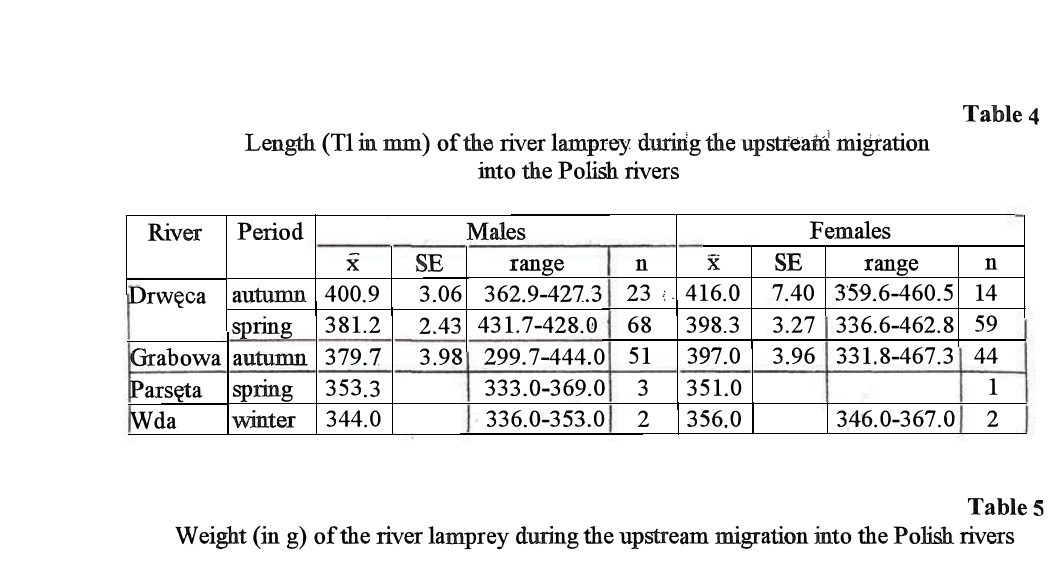
Weight (in g) of the river lamprey during the upstream migration into the Polish rivers River Period